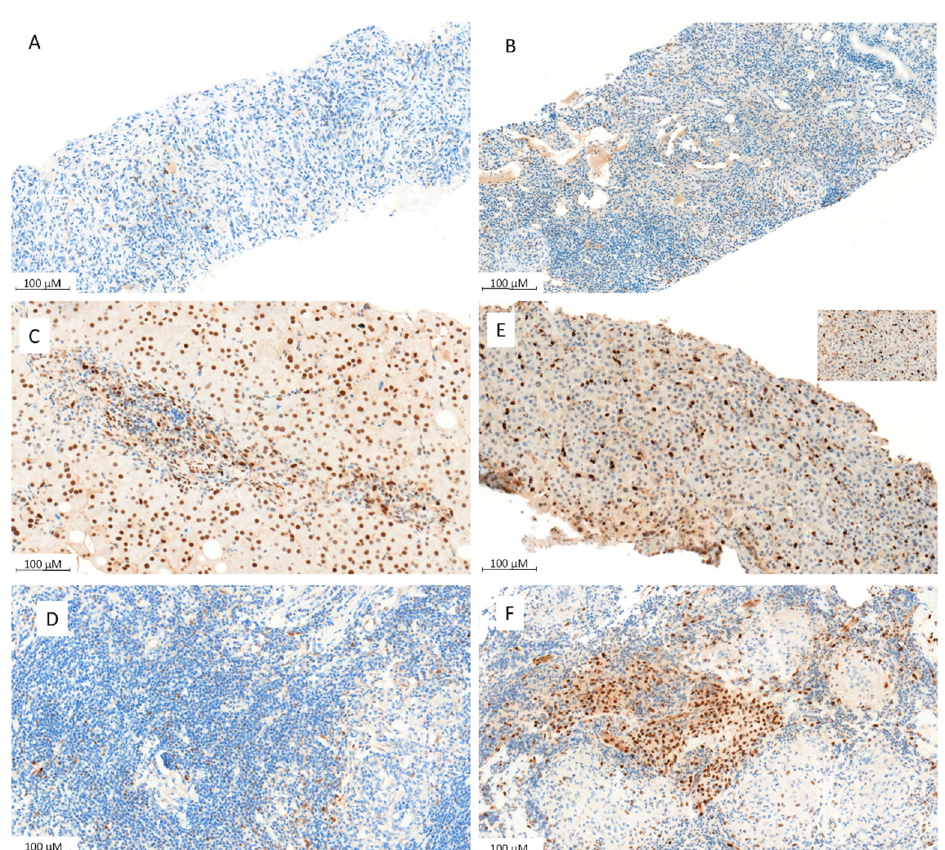
Figure 3. Phospho- STAT3 immunostaining. ( A , B ) Representative cases of p STAT3 staining in renal fibrosis showing nuclear expression in some lymphocytes and endothelial cells ( A × 150 and B × 100). ( C , D ) Representative cases of p STAT3 staining in a liver sample expressed by numerous lymphocytes and hepatocytes ( C × 200) or highlighting the intra-sinusoidal T-LGL infiltrate ( D × 150). ( E , F ) Representative cases of p STAT3 staining in inflammatory fibrosis tissue ( E × 100) and sarcoidosis-like lymph node ( F × 150) showing nuclear expression mostly in reactive lymphocytes ( D ) and histiocytes ( F ) as well as in endothelial cells.